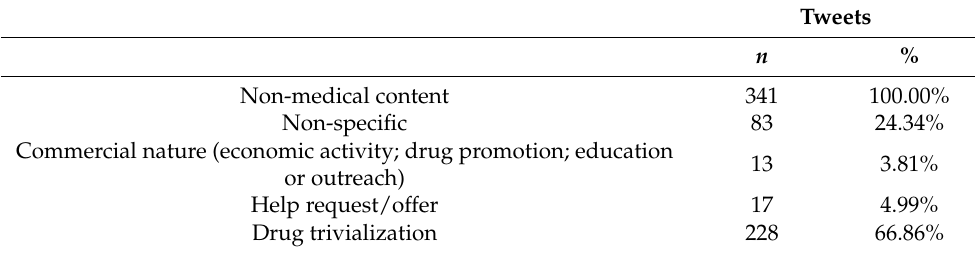
Table 2. Number and percentage of tweets by non-medical category.